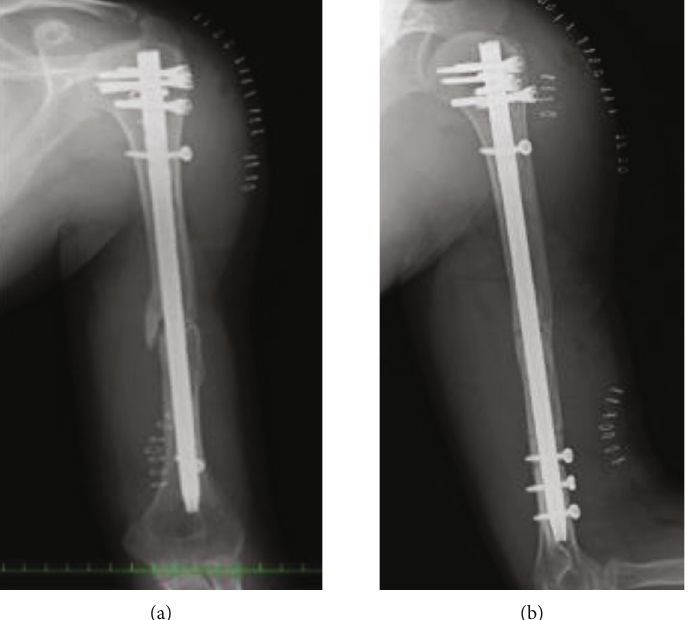
Figure 5: Radiographs just after the nonunion surgery was performed at our hospital. The gap between bone fragments seemed to be reduced by compression ((a) before nonunion surgery and (b) after the nonunion surgery). The compression screw appeared to be curved.